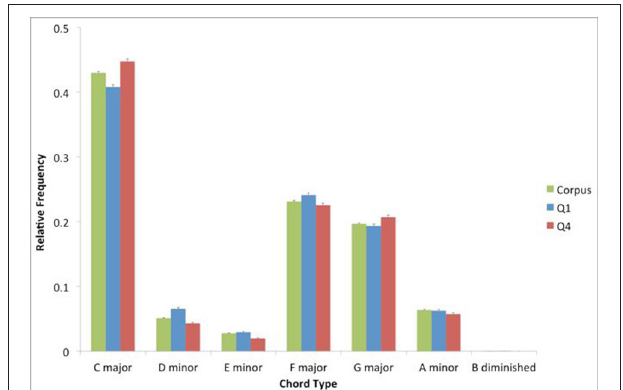
FIGURE 1 | Relative prevalence of each of the seven diatonic chords, within the entire corpus, top quartile (Q1) and bottom quartile (Q4). Error bars are standard errors. The prevalence of these chords is similar in the corpus, Q1, and